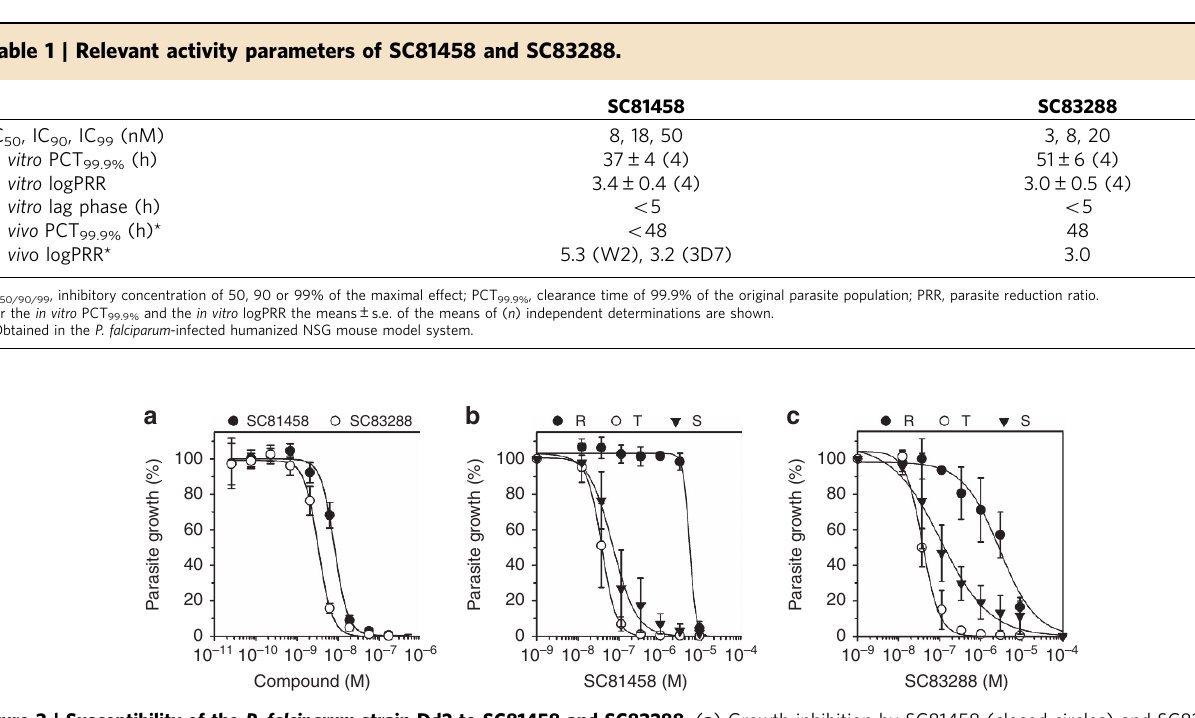
Figure 3 | Susceptibility of the P. falciparum strain Dd2 to SC81458 and SC83288. ( a ) Growth inhibition by SC81458 (closed circles) and SC83288 (open circles) in a standard cell proliferation assay with an exposure time of 72h. ( b , c ) Growth inhibition by SC81458 ( b ) and SC83288 ( c ) against rings (R, closed circles), trophozoites (T, open circles) and schizonts (S, closed inverted triangles) after an exposure time of 6h. The mean ± s.e.m. are shown for at least six independent physiological assays revealed no obvious off-target activities. transporters and receptors was low to moderate, with none The two compounds did not affect in vitro propagation of Balb C of the interactions occurring in the pharmacologically relevant 3T3 cells, HepG2 cells, human T-cells, or human peripheral blood concentration range (Supplementary Table 5). SC81458 and macrophages or showed any other signs of cytotoxicity at a fixed SC83288 did not block human cardiac hERG-mediated concentration of 50 m M. They (10 m M) did not interfere with any K þ conductance. hERG retained 4 90% of its activity at a concentration of 60 and 20 m M for SC81458 and SC83288, of the 401 human kinases examined in a competition assay respectively. At a concentration of 100 m M of SC83288 the (Supplementary Table 4). The binding potential to 54 human